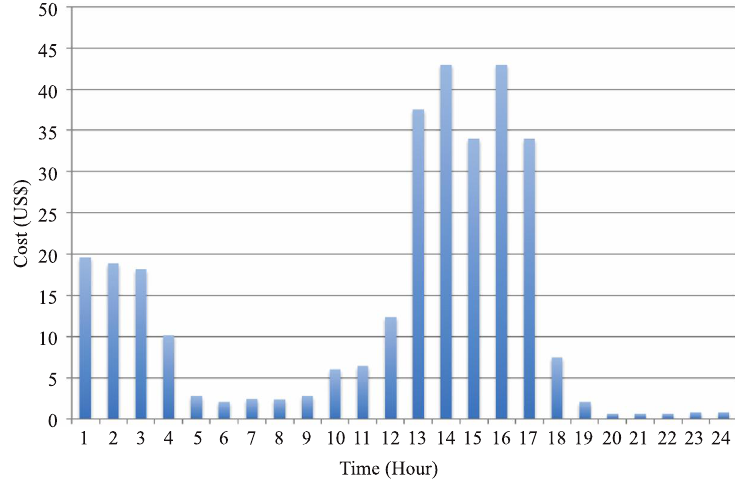
FIG. 2. PER UNIT COST OF ELECTRICITY ACCORDING TO DIFFERENT TIME SLOTS OF A DAY